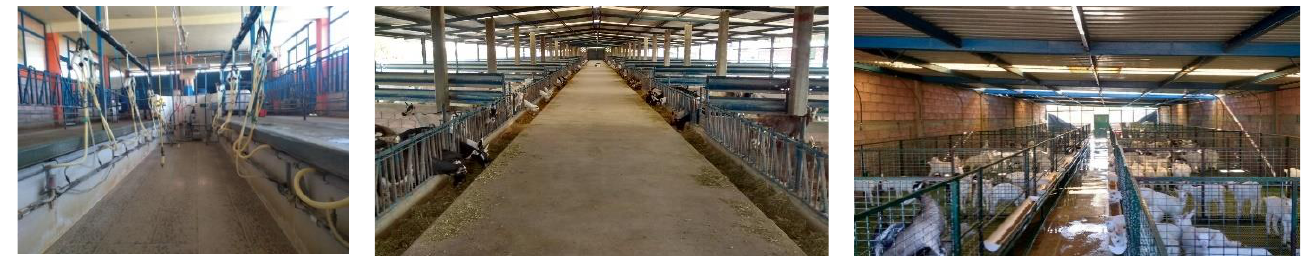
Figure 4. Intensive goat farming system from “ Granja Puente Colorado ” , located in Guanajuato of central Mexico and incorporated in the Guanajuato´s United Goat Farmers Association. This farm has been performing genetic improvements on different pure breeds. The main income comes from selling live animals, which is followed by fresh milk sales. As shown in the pictures (milking parlor (left), pens for adult goats (middle), and kid raising (right)), there has been great investment put into infrastructure and biosecurity to preserve animal welfare and health.